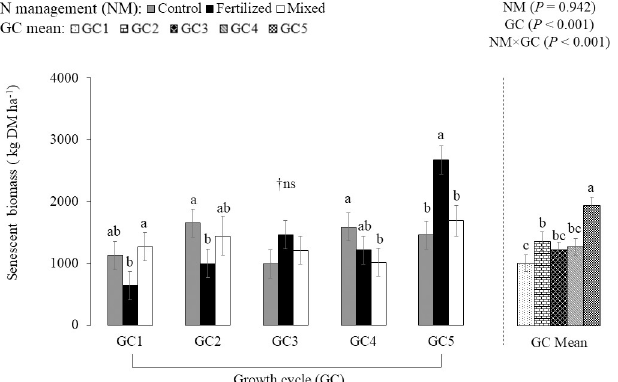
Fig 4. Nitrogen management strategies (NM) × growth cycle (GC) interaction effect on senescent biomass of palisadegrass (mean ± SE bars). Control: palisadegrass without N fertilizer or legume; Fertilized: palisadegrass fertilized with 150 kg N ha -1 year -1 ; and Mixed: palisadegrass mixed with forage peanut and no N fertilizer. †Non- significant. Data are means across 2 years, and 4 replicates (n = 8). Means sharing the same letter within GC are not different, according to the PDIFF procedure by LSD test ( P �